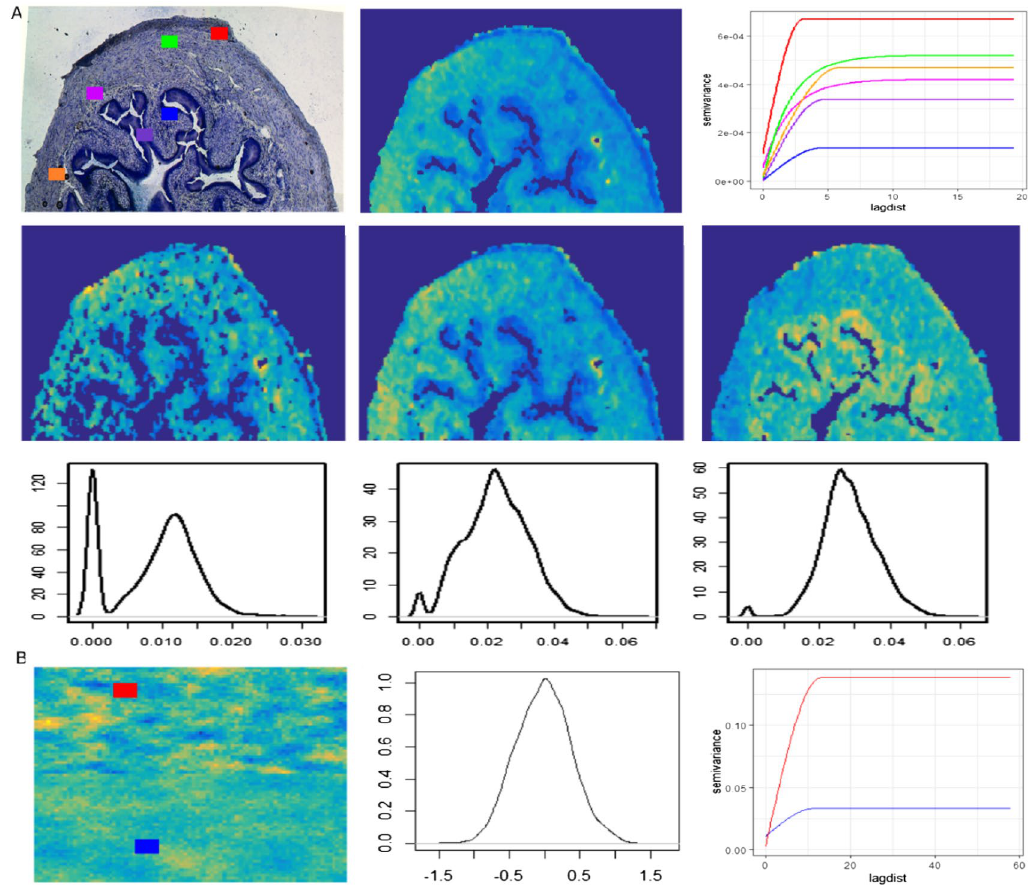
Figure 3. Comparison of statistical (distribution) and spatial (variograms) properties of variables from real MSI (a) and synthetic spatial data (b). ( A ) Top row: The variograms (right) of an example single ion (middle) from different regions are shown in its histology image (left). Middle row: the 2D image of a few molecular ions from real MSI data and their density plot in the bottom row. ( B ) The synthetic spatial data image (left), density plot (middle), and the variograms (right) from synthetic data. The variograms (left column) and density plots (middle column) from synthetic